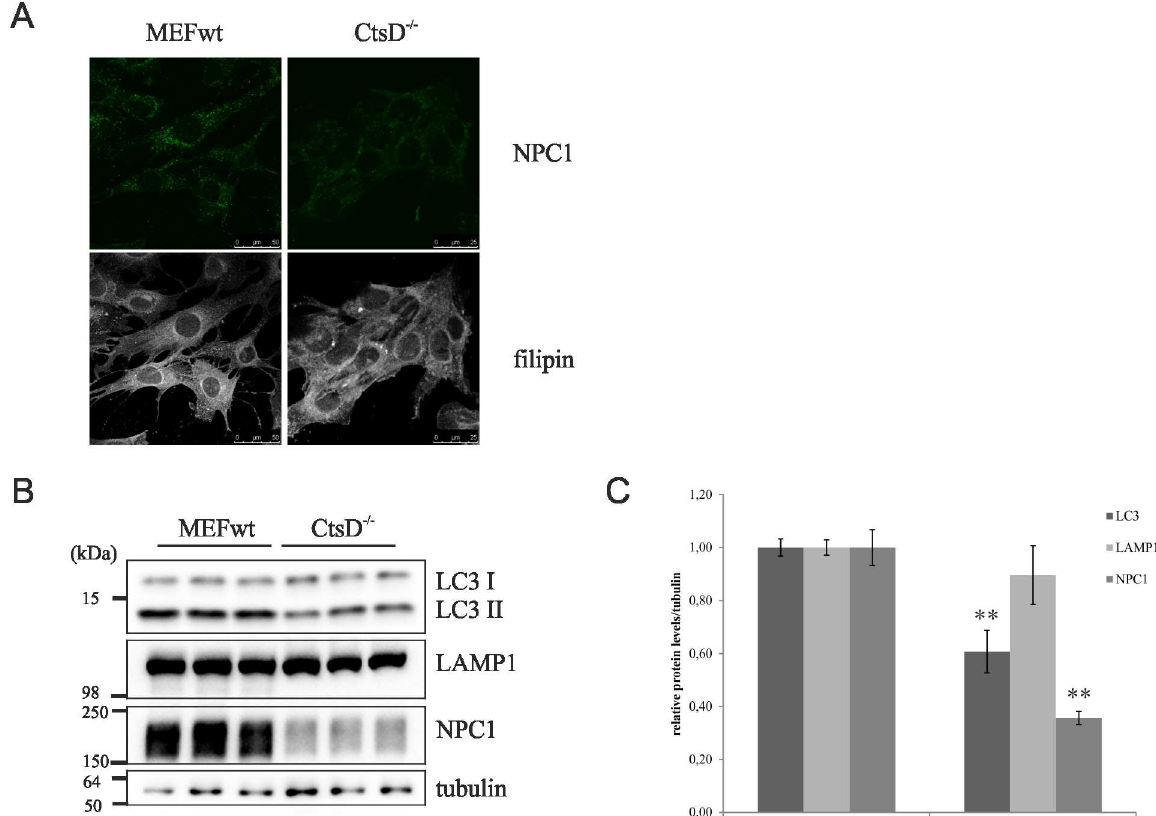
Fig 5. Cathepsin D genetic depletion in MEF cells does not cause cholesterol nor lysosomal proteins accumulation. (A) Confocal microscopy of CtsD KO MEFs. Cholesterol (filipin staining, white) and NPC1 (green). (B) Western blot analysisof CtsD KO MEFs using LC3, LAMP1 and NPC1 antibody. α -Tubulinwas used as a loadingcontrol. (C) Quantificationof Western blot results of the 3 independentexperiments was performed by ImageJ. Student t-test was used for statistical analysis. Error bars present the mean ± standarddeviation( ** p <